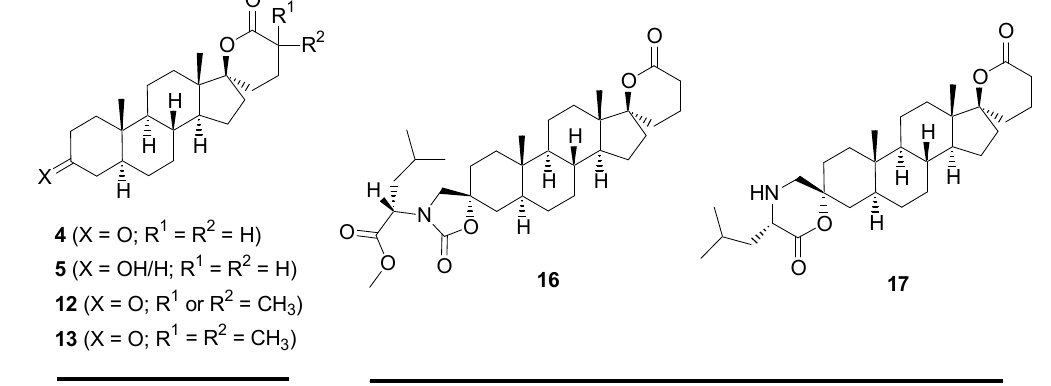
Figure 2. Chemical structures of potential inhibitors of 17 β -HSD5 or 17 β